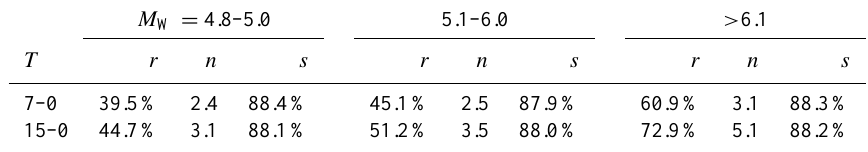
Table 7. The statistical results concerning seismic ionospheric influences on the ion density ( D = 0–1500km, d = 0–1000km). M W =